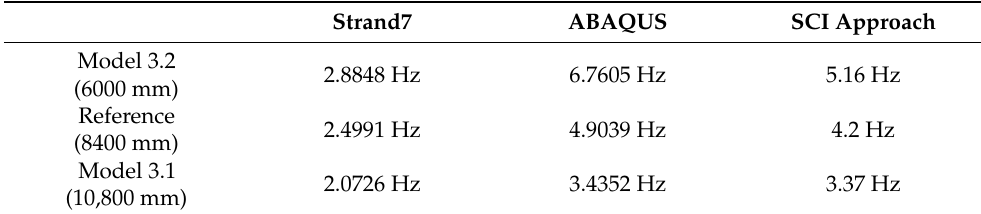
Table 8. Comparison of Fundamental Frequency between Different Secondary Beam Lengths.